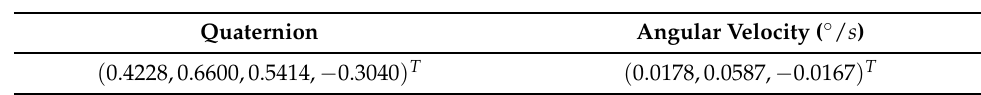
Table 4. Initial